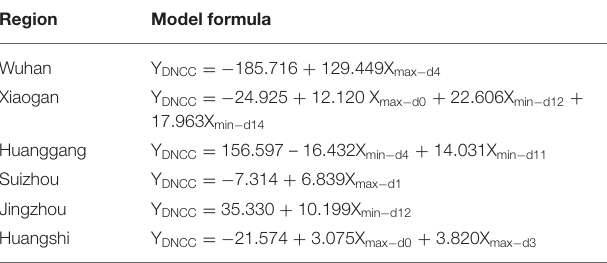
TABLE 3 | Statistical data of the linear regression equation in Hubei. Region Model